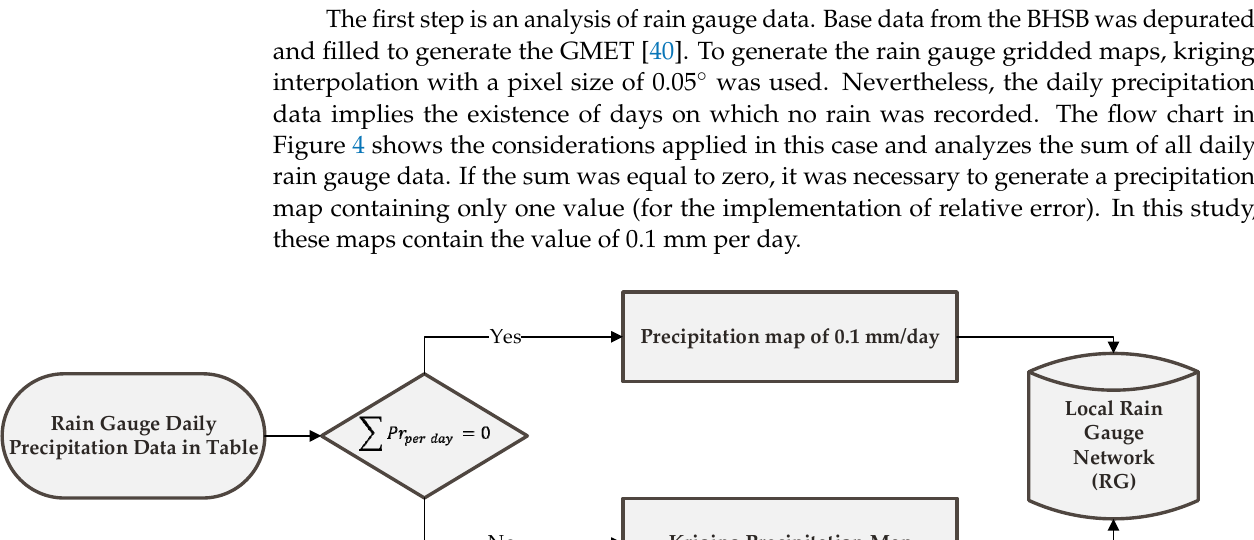
Figure 3. ( a ) Sub-basins using the Pfafstetter coding system (Level Four) and prioritized basins; ( b ) rasterized sub-basin map.